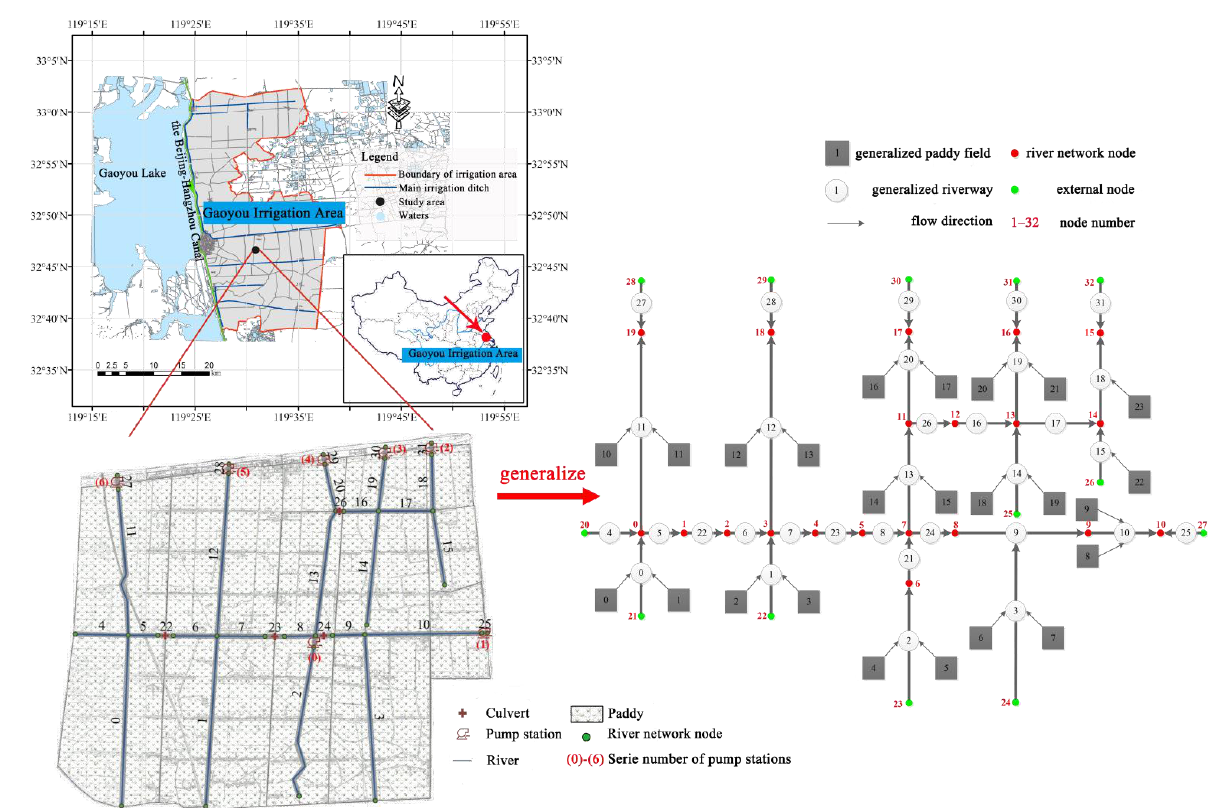
Figure 1. Study area map and drainage system generalization.